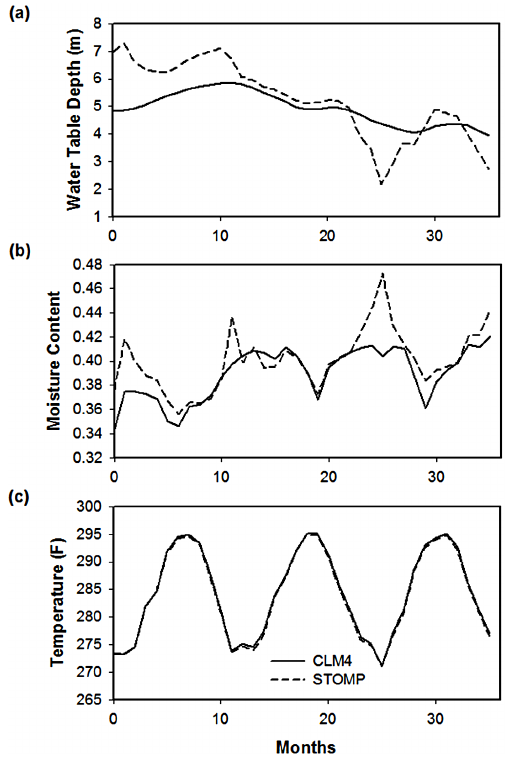
Figure 6. Comparison of water table depth (a) , average soil mois- ture content (b) , and average soil temperature (c) using the original soil hydrology model and STOMP in CLM4 at site US-IB1.